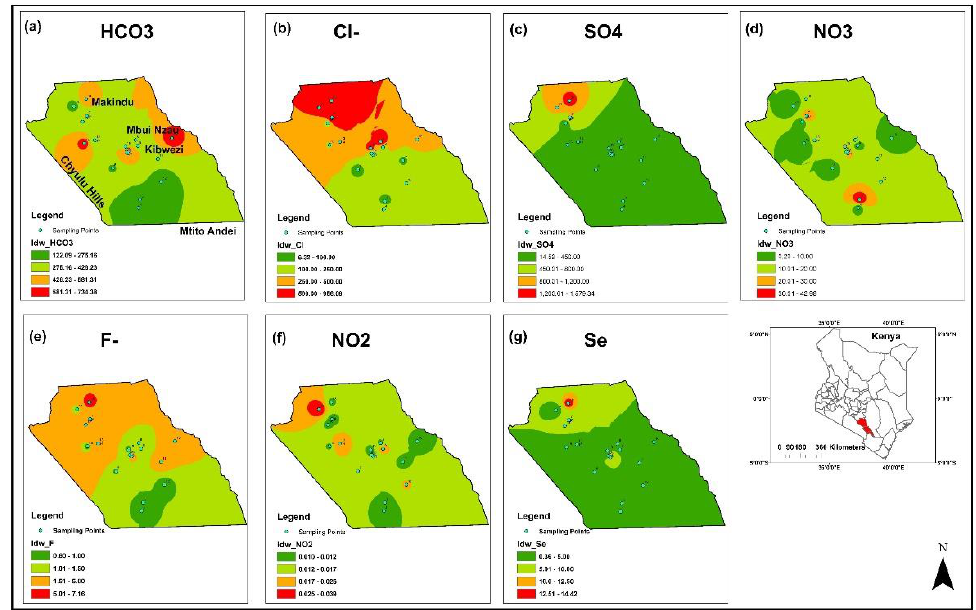
Figure 4. Spatial variation of HCO 3 − ( a ), Cl − ( b ), SO 42 − ( c ), NO 3 − ( d ), F − ( e ), NO 2 − ( f ), and Se ( g ) in groundwater in Makueni County in November 2018 where, areas in red exceed the recommended limits for drinking water of these anions.